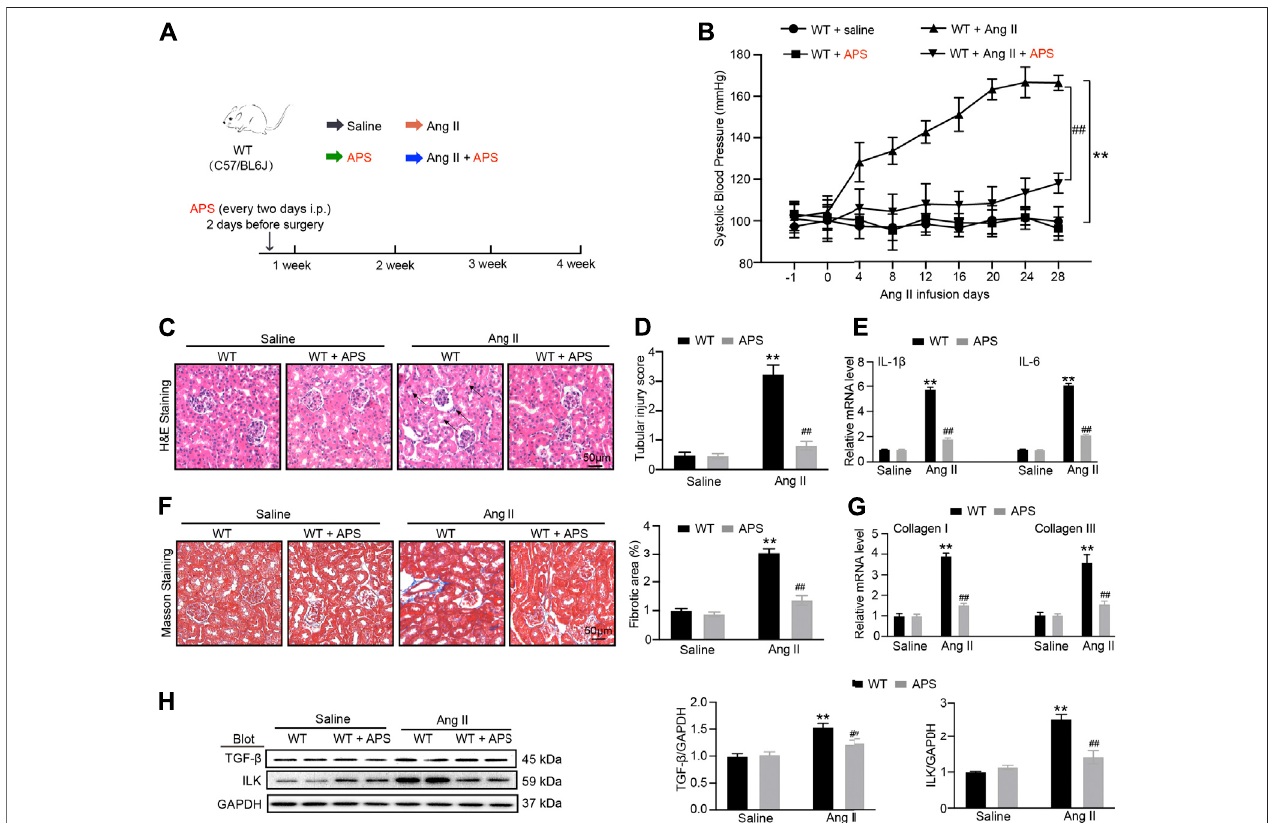
FIGURE5 | Treatmentwith APSprevents AngII-inducedhypertension. (A) Diagrammatic representation oftreatment ofdifferentgroups ofmice: saline, APS, Ang II,andAngII+APS. (B) AveragesystolicbloodpressureofeachgroupbeforeandafterAngIItreatmentobtainedbytelemetry( n (cid:1) 6pergroup). (C) H&Estainingofeach group were analyzed (scale bar 50 μ m, n (cid:1) 6 per group). (D) Tubular injury score was computed from the percentage of damaged tubulars. Based on the different degrees of tubular injury, the score was divided into 0, normal; 1, < 10%; 2, 11 – 25%; 3, 26 – 75%; 4, > 75% ofthe observed tubules. (E) qPCR analysis of IL-1 β and IL-6 mRNA expression levels in the kidney ( n (cid:1) 6). (F) Masson stainingof each group was analyzed (right, scale bar 50 μ m). Percentage of the fi brotic area was analyzed (left, n (cid:1) 6pergroup). (G) qPCRanalysisofcollagenIandcollagenIIImRNAexpressionlevelsinthekidney( n (cid:1) 6). (H) ImmunoblottinganalysisofTGF- β 1andILKprotein in each group ( n (cid:1) 4 per group). ** P < 0.01 versus control mice. ## P < 0.01 versus Ang II + APS